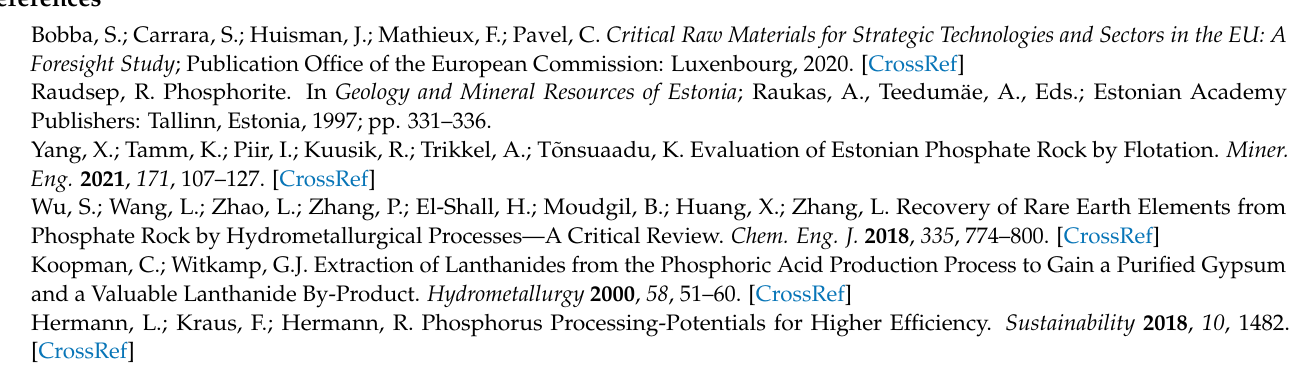
Table S2: Solubility data of Ülgase. Table S3: Final pH and solubility data of Toolse